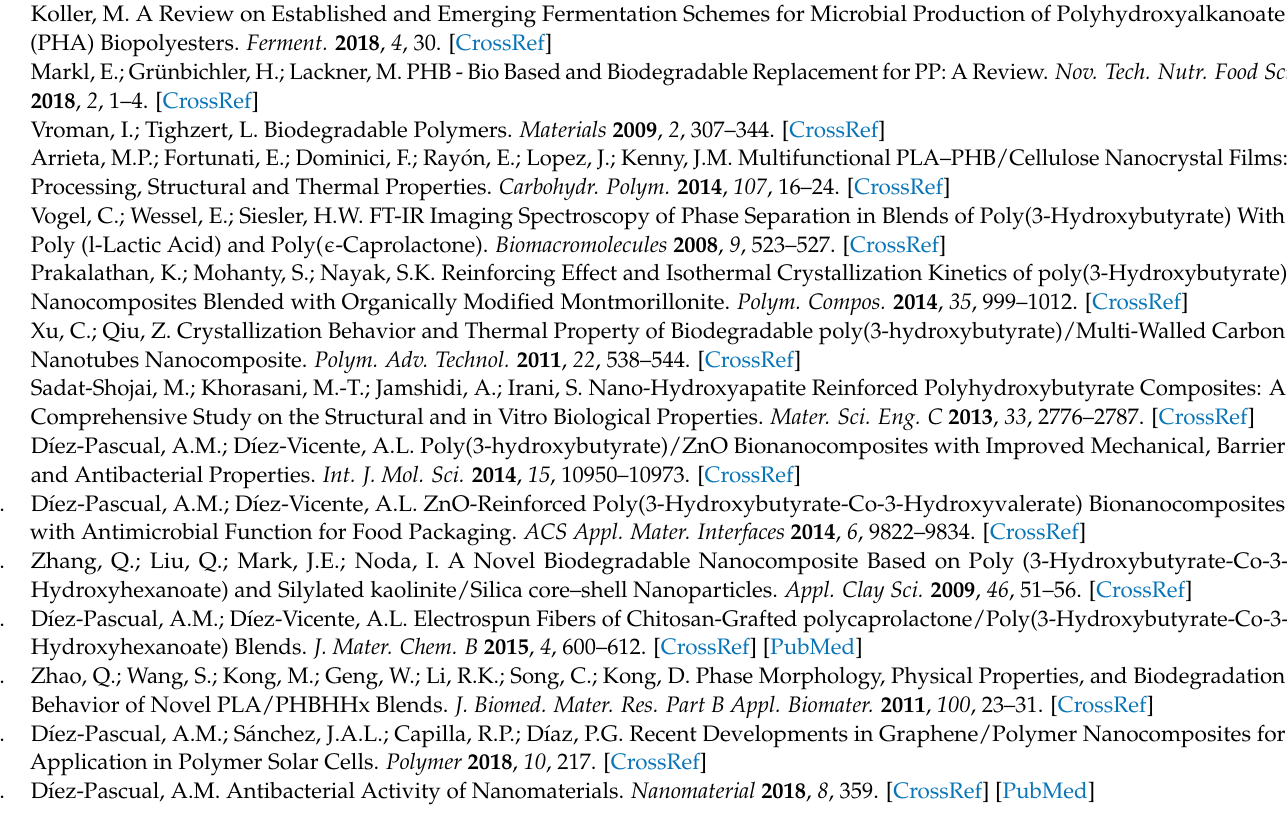
Figure S2: Histograms of the thickness distribution obtained from GO nanosheets, Figure S3: Area under the tensile curve as a function of GO